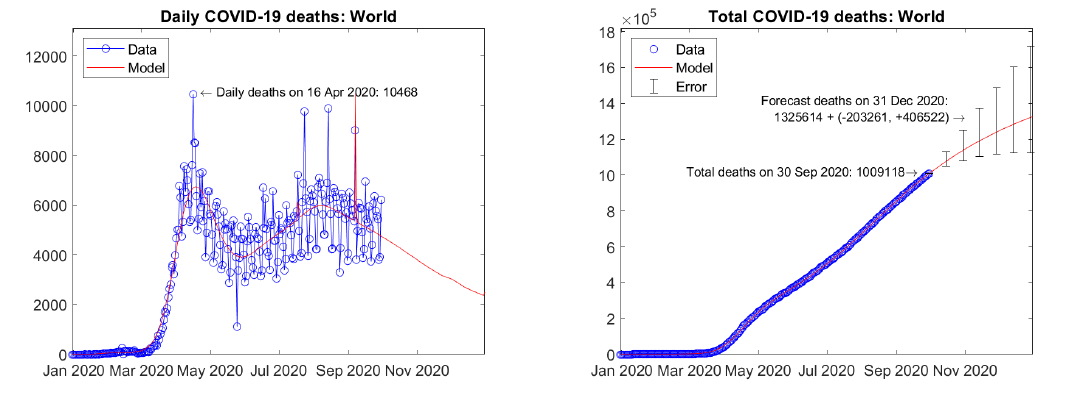
Figure 34. Actual and predicted trends in the World: ( a ) daily deaths, ( b ) total